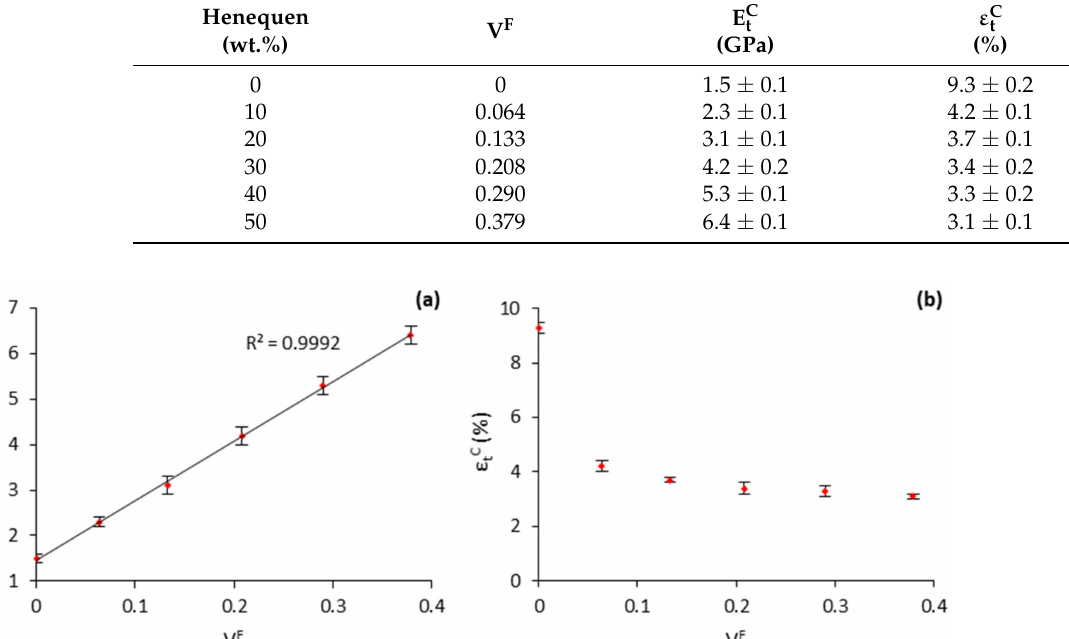
t ) with the fiber volume